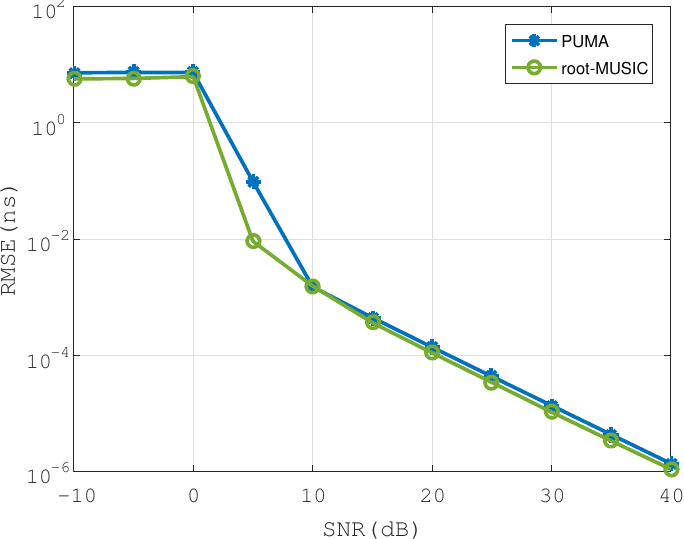
Figure 3. RMSE versus SNR, K = 3, all echoes uncorrelated (Scenario 1), N = 150, B = 3GHz.